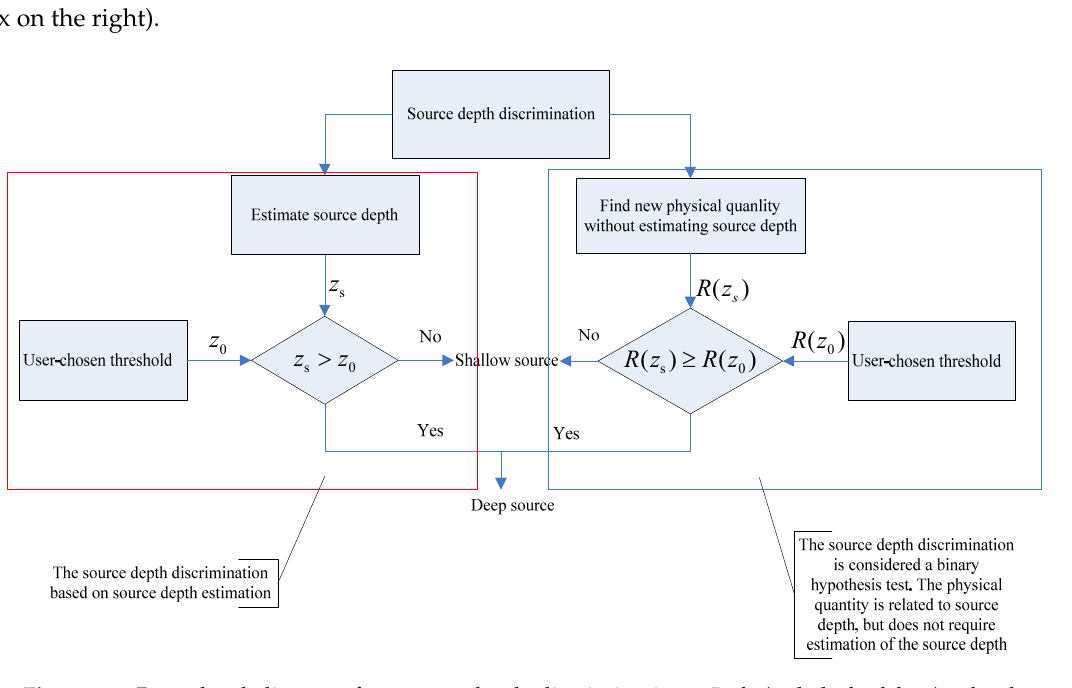
Figure 2. Procedural diagram for source depth discrimination. Left (red dashed box): depth discrimination based on depth estimation. Right (blue dashed box): depth discrimination based on binary testing hypotheses.